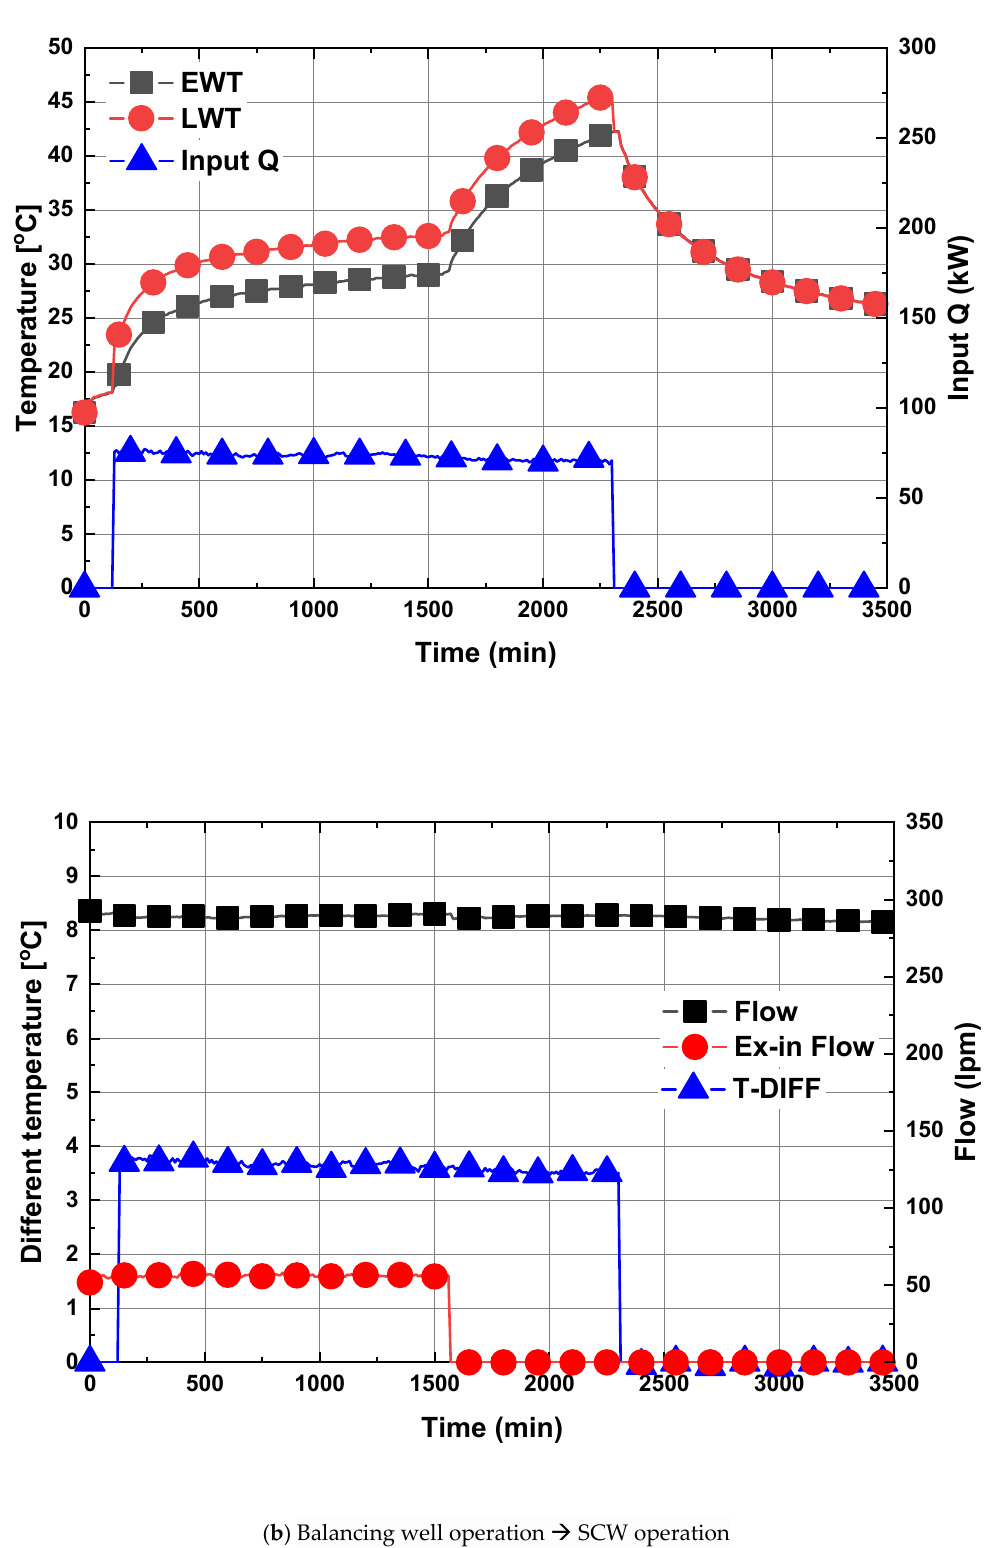
Figure 7. Operating characteristics of the SCW and cross-mixing balancing well geothermal heat exchanger affecting the thermal environmental characteristics of the ground.